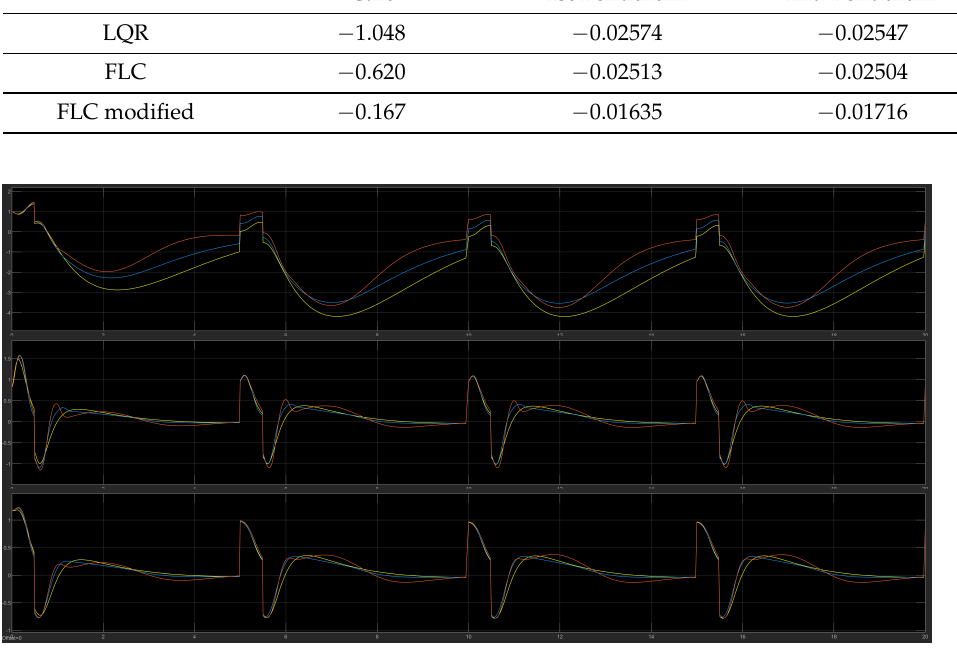
Figure 30. The DIP response under disturbance (third placement point) in the control signal with the LQR (yellow), FLC (blue) and modified FLC* (orange)